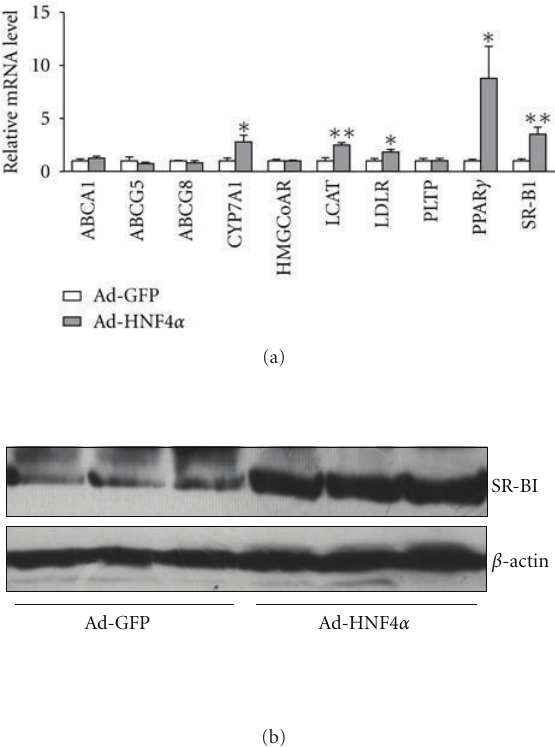
Figure 4: Expression pattern of hepatic cholesterol-regulatory genes under HNF4 α overexpression in rat liver. (a) Total RNA was extracted from rat liver and the mRNA levels of hepatic cholesterol- regulatory genes, including HMGCoAR, LCAT, PLTP, LDLR, SR-BI, ABCA1, ABCG5, ABCG8, and CYP7A1, were measured by qPCR. Data are mean ± SEM mRNA levels normalized to that of β -actin and expressed as fold of GFP-infected group. ∗ P < 0 . 05. (b) Rat liver extracts were examined by western blot analysis with antibodies against SR-BI or β -actin.